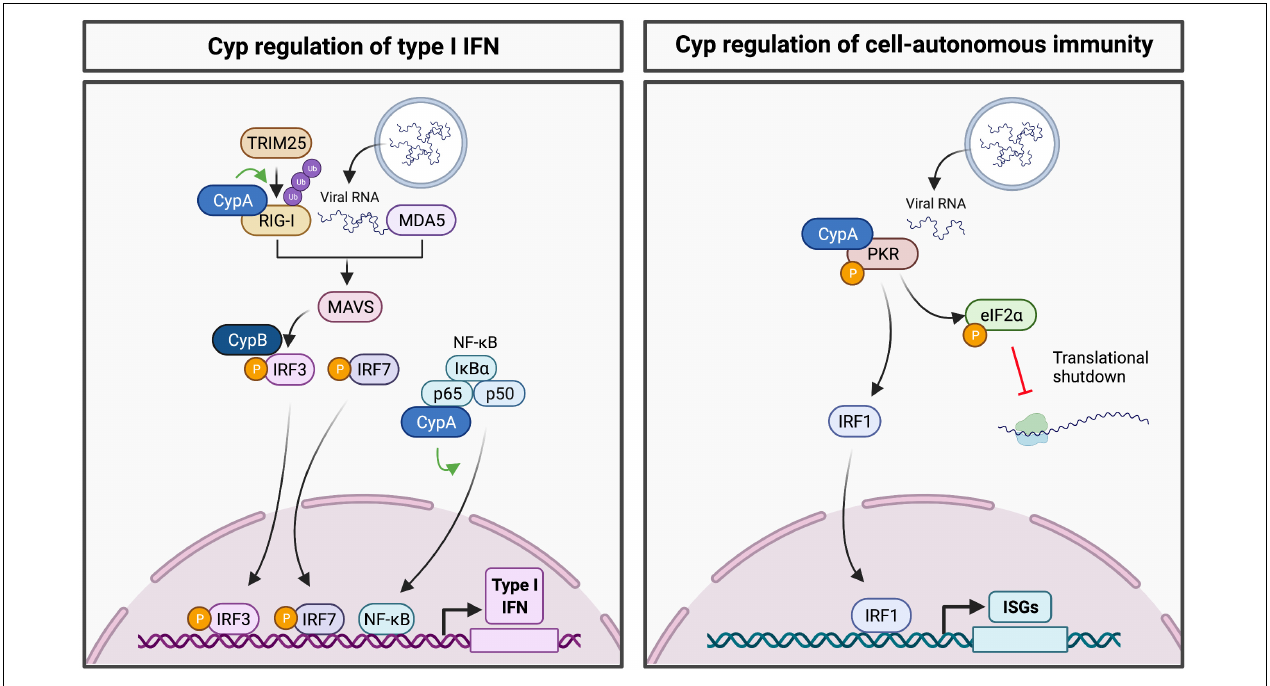
FIGURE 1 | Regulation of innate immune signaling pathways by cyclophilins. (Left panel) Cyps have been shown to regulate RIG-I, IRF3 and NF- κ B, thus contributing to activation of the type I IFN response. (Right panel) CypA regulates PKR activation to promote eIF2 α phosphorylation and translational shutdown. Downstream of PKR, cyclophilin inhibitor treatment appears to activate transcription of ISGs in a PKR and IRF1-dependent